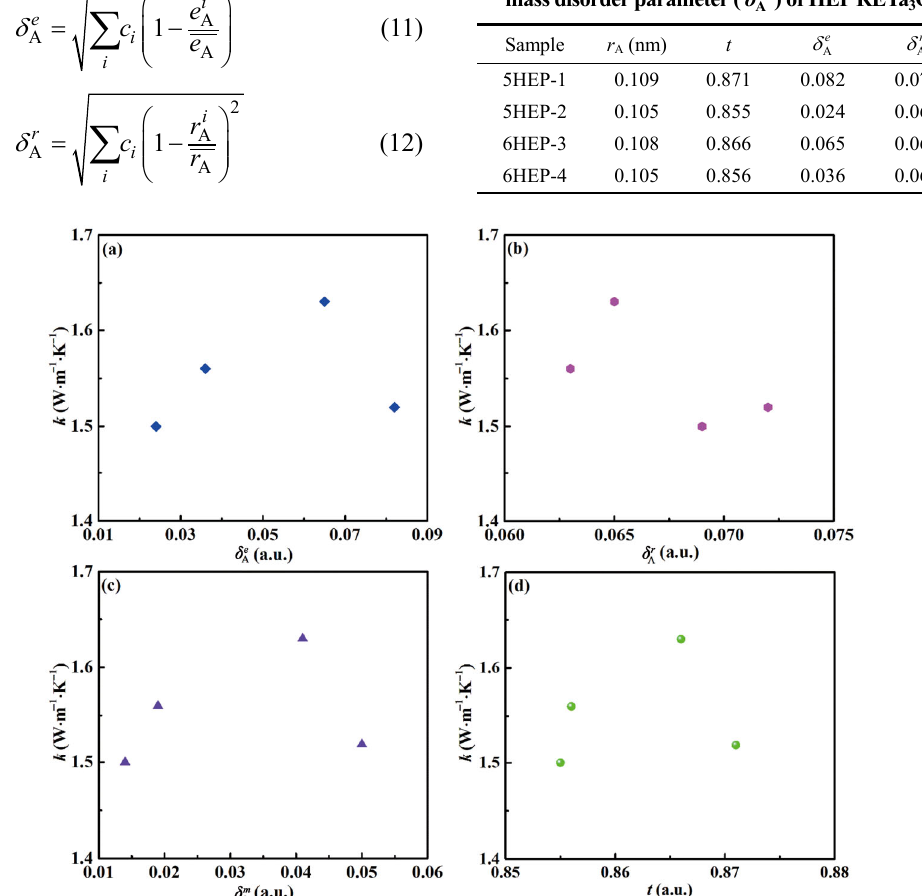
Fig. 9 Variation trends in thermal conductivity with different parameters of (La 1/5 Pr 1/5 Dy 1/5 Ho 1/5 Tm 1/5 )Ta 3 O 9 (5HEP-1), (Gd 1/5 Dy 1/5 Ho 1/5 Er 1/5 Tm 1/5 )Ta 3 O 9 (5HEP-2), (La 1/6 Sm 1/6 Eu 1/6 Dy 1/6 Ho 1/6 Tm 1/6 )Ta 3 O 9 (6HEP-3), and (Eu 1/6 Gd 1/6 Dy 1/6 Ho 1/6 Er 1/6 Tm 1/6 )Ta 3 O 9 (6HEP-4) ceramics: A-site atomic disorder parameters of (a) electronegativity, (b) ionic radius, and (c) atomic mass; (d) tolerance